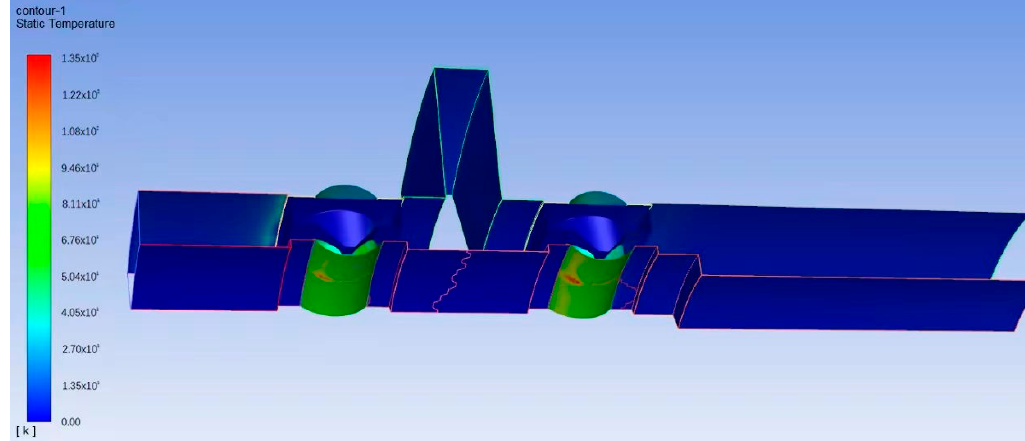
Figure 25. Experimental results for the temperature of the outer ring under 16,000 rpm and 17,000 rpm. Figure 23. LN2 flow lines. Figure 24. Temperature